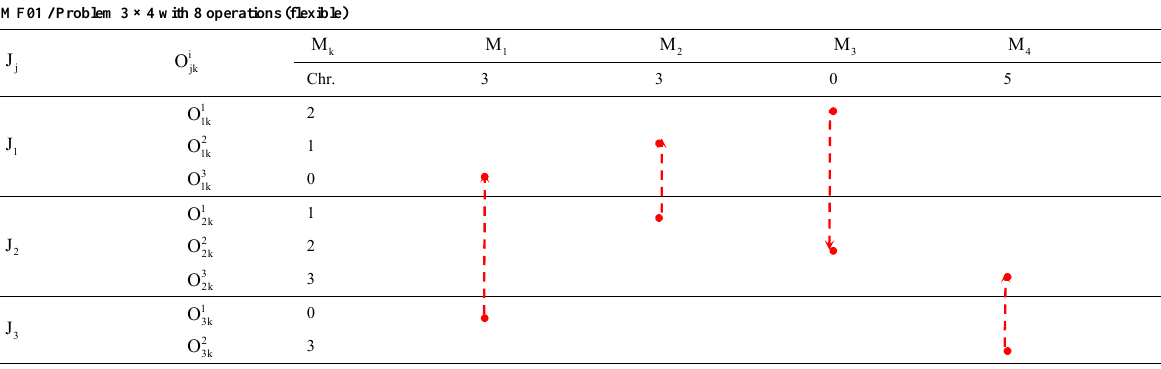
Allocation and Sequencing Chromosomes for the FJSSP MF01 / Problem 3 × 4 with 8 operations (flexible) j